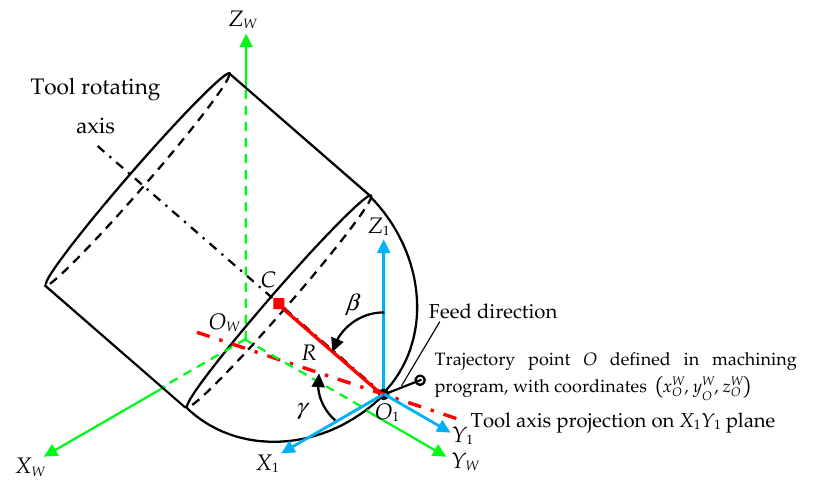
Figure 9. 5-axis milling scheme with tool tilt angle β and lead angle γ .